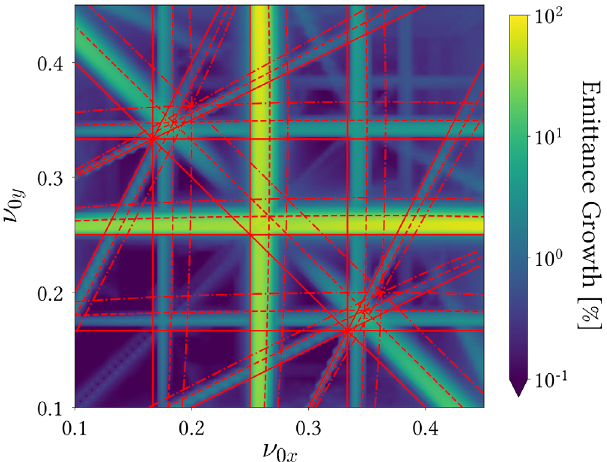
FIG. 4. Tune diagram obtained from 2D W ARP simulations with a fixed beam intensity and fixed rms emittances at injection. The initial intensity and emittances are maintained everywhere on the diagram at the values that give η x ¼ η y ¼ 0 . 9 at the operating point ð ν 0 x ; ν 0 y Þ ¼ ð 1 = 6 ; 1 = 6 Þ . The tune depressions are no longer constant but vary depending on the cell tunes. Other numerical conditions and the definitions of the red lines are the same as in Fig.